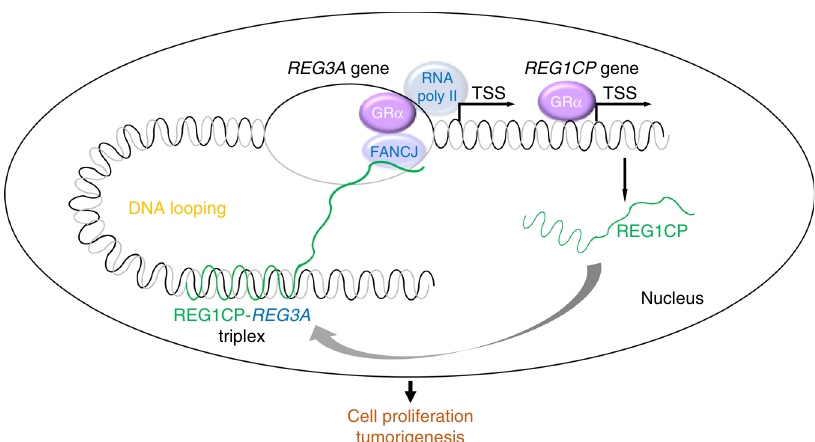
Fig. 8 Schematic illustration of the function of REG1CP. REG1CP acts as a two-stage address code to facilitate REG3A transcription through assembling a long-range enhancer complex via forming an RNA – DNA triplex with the REG3A gene. DNA looping through structural folding of the REG3A DNA is proposed to facilitate the speci fi c targeting of FANCJ to the transcriptionally active region